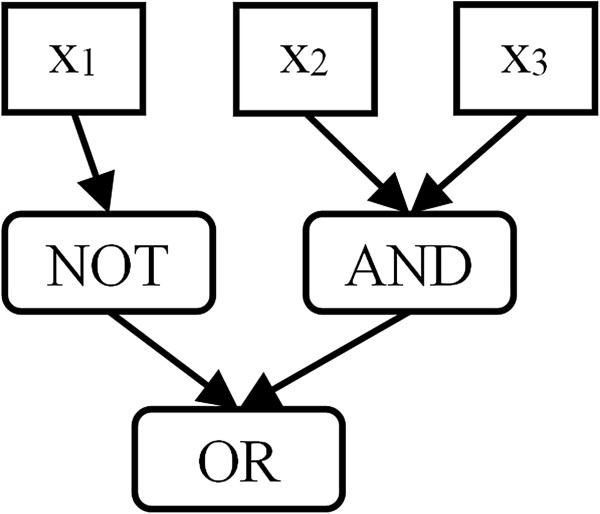
A Boolean tree for the function B1(x1, x2, x3) = (NOT x1) OR (x2 AND x3). Input variables xi are connected by Boolean operators. The OR node is the root of the tree, i.e. its value determines the value of the function represented by the tree.